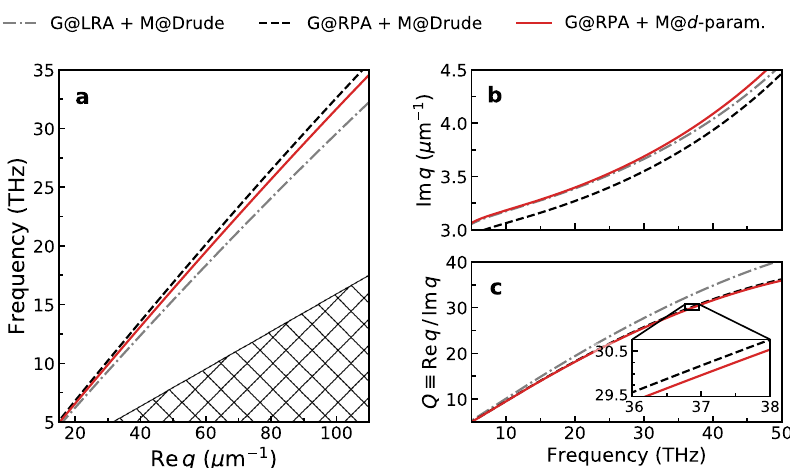
Fig. 2 In fl uence of metallic quantum surface-response on the dispersion of acoustic graphene plasmons (AGPs). Three increasingly sophisticated tiers of response models are considered: (i) classical, local response for both the graphene and the metal [gray dot-dashed line]; (ii) nonlocal RPA and local Drude response for the graphene and the metal, respectively [black dashed line]; and (iii) nonlocal RPA and d -parameter-augmented response for the graphene and the metal, respectively [red solid line]. a AGP dispersion diagram, ω /(2 π ) versus Re q . The hatched region indicates the graphene ’ s electron – hole continuum. b Associated imaginary part of the AGP wavevector, Im q . c Corresponding quality factor Q (cid:2) Re q = Im q . The inset shows a zoom of the indicated region. System parameters: we take a graphene – metal separation of t = 1 nm; for concreteness and simplicity, we consider an unscreened jellium metal with plasma frequency _ ω p ≈ 9.07 eV (corresponding to r s = 3) where ζ ≈ 0.8 Å and ξ ≈ 0.3 Å 24 , with Drude-type damping _ γ m = 0.1 eV; for graphene, we take E F = 0.3 eV and _ γ = 8 meV; fi nally, we have assumed ϵ d ≡ ϵ 1 = ϵ 2 = 1 (for consistency with the d -parameter data which assumes a metal – vacuum interface 24